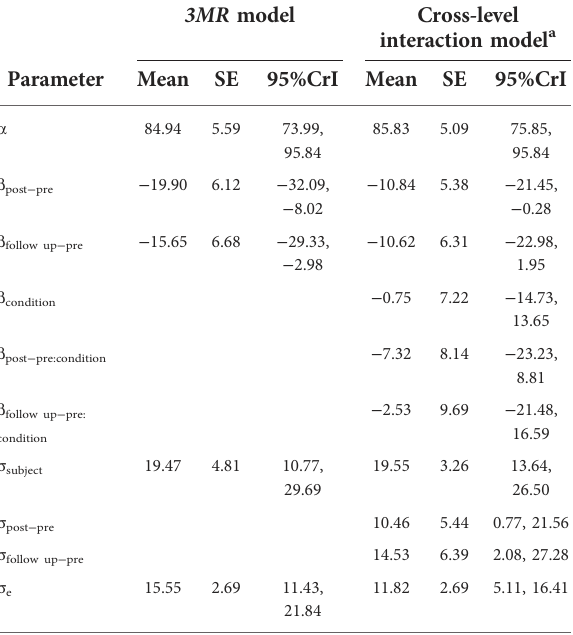
TABLE 6 Posterior mean, standard error, 95% credible interval for each parameter in model predicting OQ-45-2